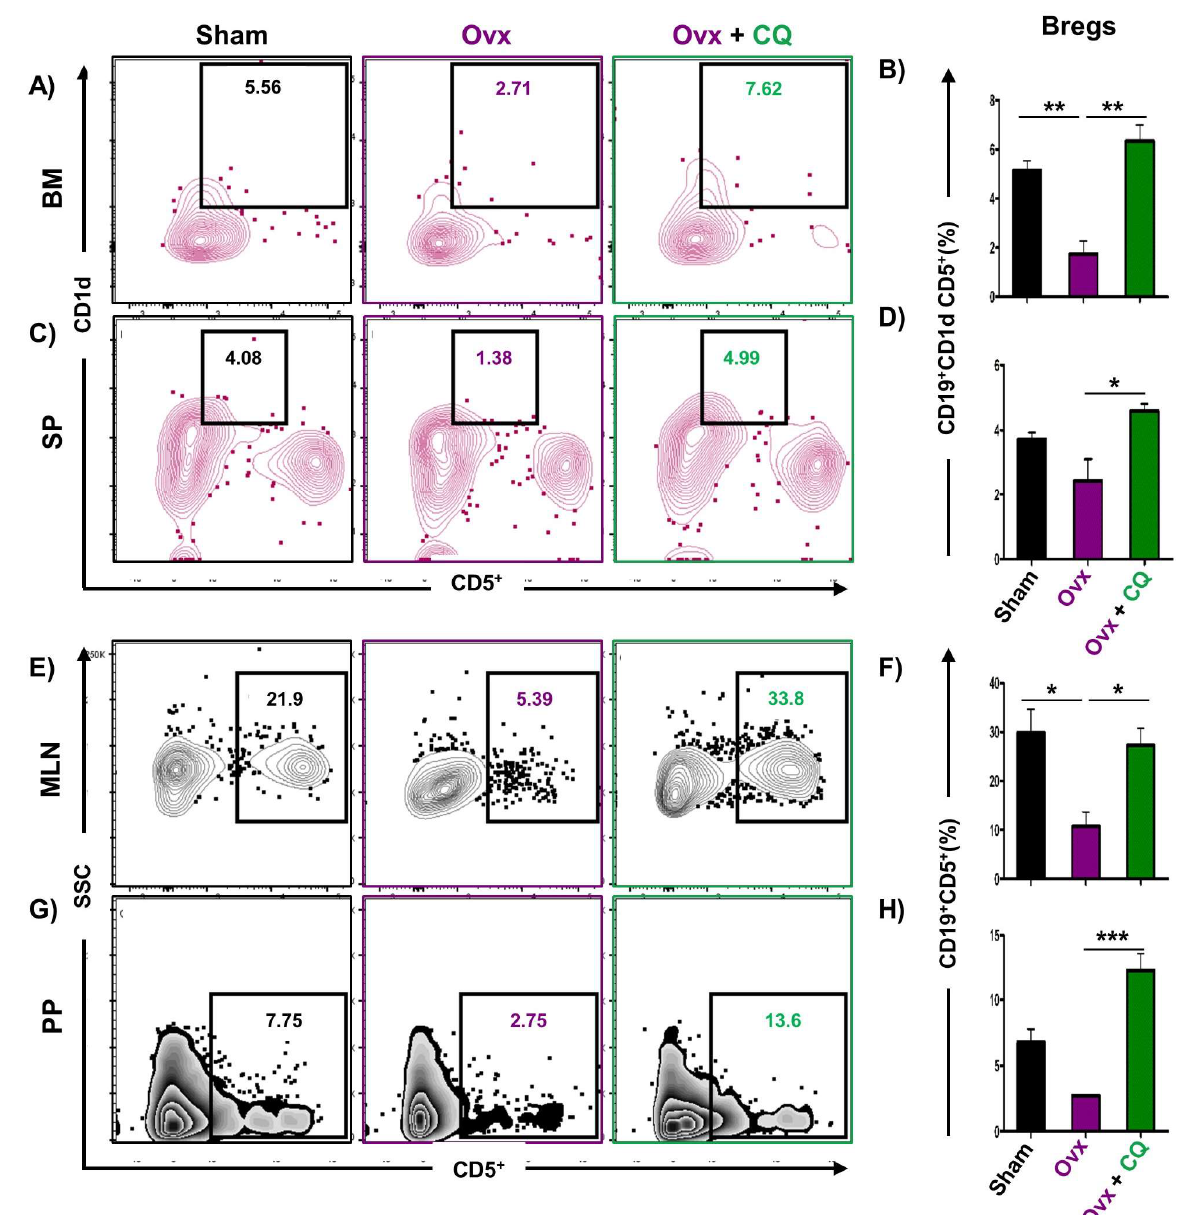
Figure 8. CQ intake enhances Bregs in Ovx mice : Cells harvested from the lymphoid organs of all the groups were analyzed by flow cytometry for the percentage of CD19 + CD1d hi CD5 + Bregs immune cells. ( A ) Contour plot representing the percentage of CD19 + CD1d hi CD5 + Bregs in BM. ( B ) Bar graphs representing the percentage of CD19 + CD1d hi CD5 + Bregs in BM. ( C ) Contour plot representing the percentage of CD19 + CD1d hi CD5 + Bregs in SP. ( D ) Bar graphs representing the percentage of CD19 + CD1d hi CD5 + Bregs in SP. ( E ) Contour plot representing the percentage of CD19 + CD5 + Bregs in MLN. ( F) Bar graphs representing the percentage of CD19 + CD5 + Bregs in MLN. ( G ) Contour plot representing the percentage of CD19 + CD5 + Bregs in PP. ( H ) Bar graphs representing the percentage of CD19 + CD5 + Bregs in PP. ANOVA was used to analyse the results, and then unpaired Student t-tests were used to compare the indicated groups. Values are expressed as mean ± SEM, and equivalent outcomes were observed in two independent experiments. For the indicated groups, p 0.05 (* p ≤ 0.05, ** p ≤ 0.01, *** p ≤ 0.001) was used as the cutoff for statistical significance.